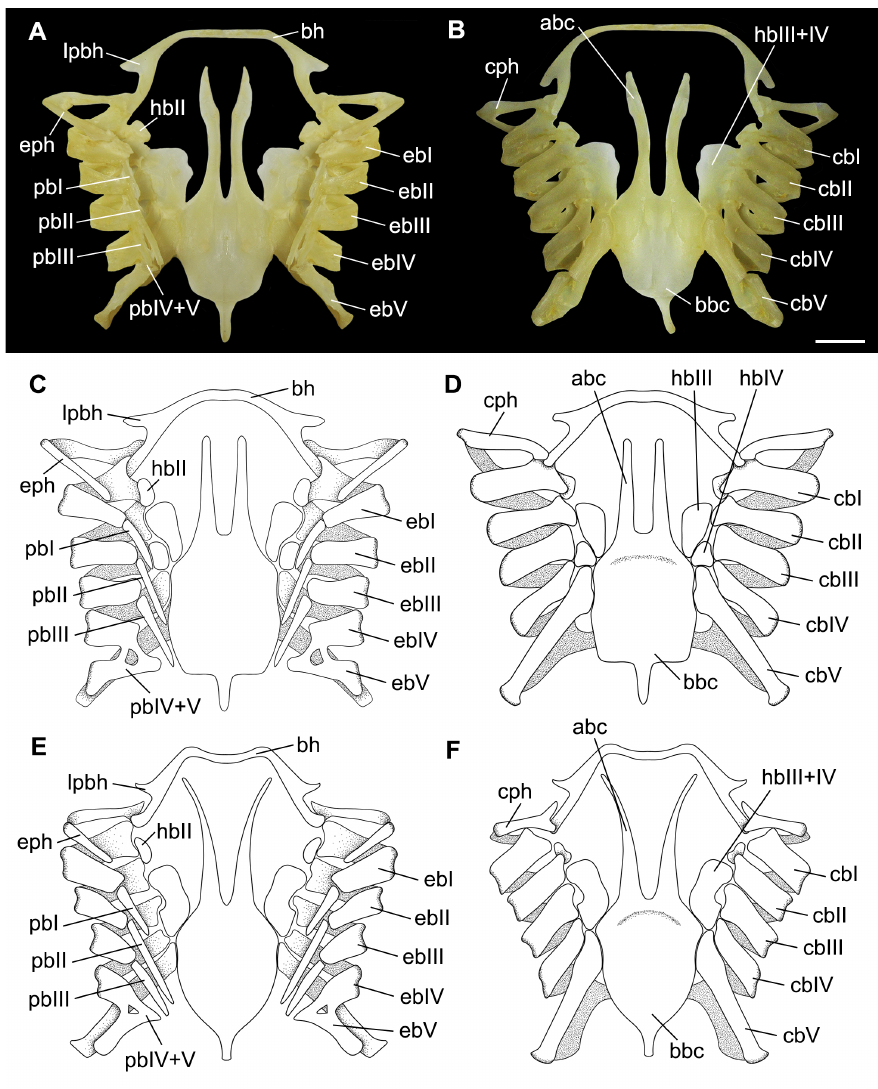
FIGURE 19 | Hyoid and gill arches of Atlantoraja species. A , B. A. cyclophora , MNRJ 117184, female, 583 mm TL. C , D . A. castelnaui , UERJ 1853, male, 593 mm TL. E , F. A. platana , UERJ 1383, male, 372 mm TL. abc , anterior portion of basibranchial copula; bbc , basibranchial copula; bh